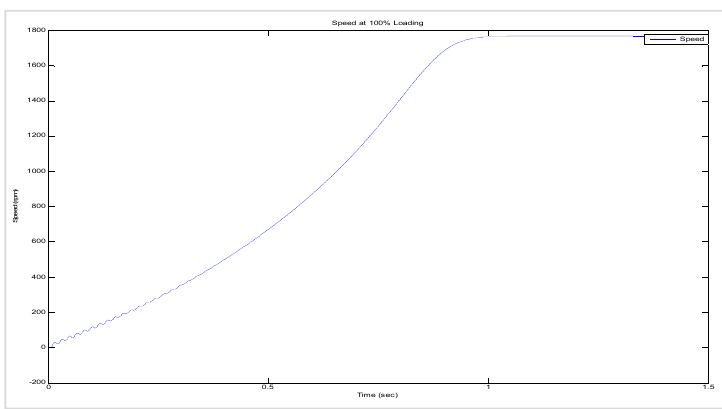
Figure 22. The speed at 100% loading. 8.3. Dynamic Behaviour of the Machine When (i) the Load Was Suddenly Changed from 50% to 100% and (ii) the Supply Voltage (for the Motors) or the Torque Input (for the Generators) Was Suddenly Halved While the Load Was Maintained at 100%